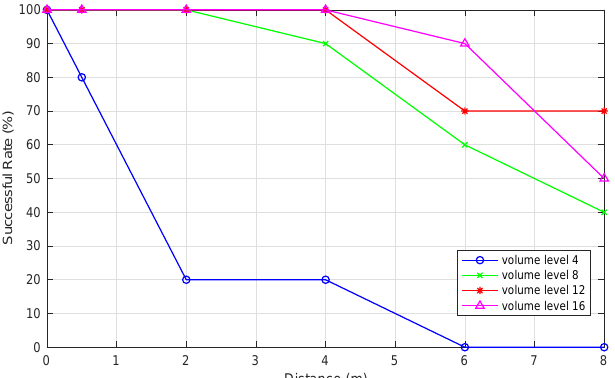
Figure 6. The relationship between the success rate of receiving sub-ultrasonic by smartphones and sub-ultrasonic transmission distance with different smartphone volumes.